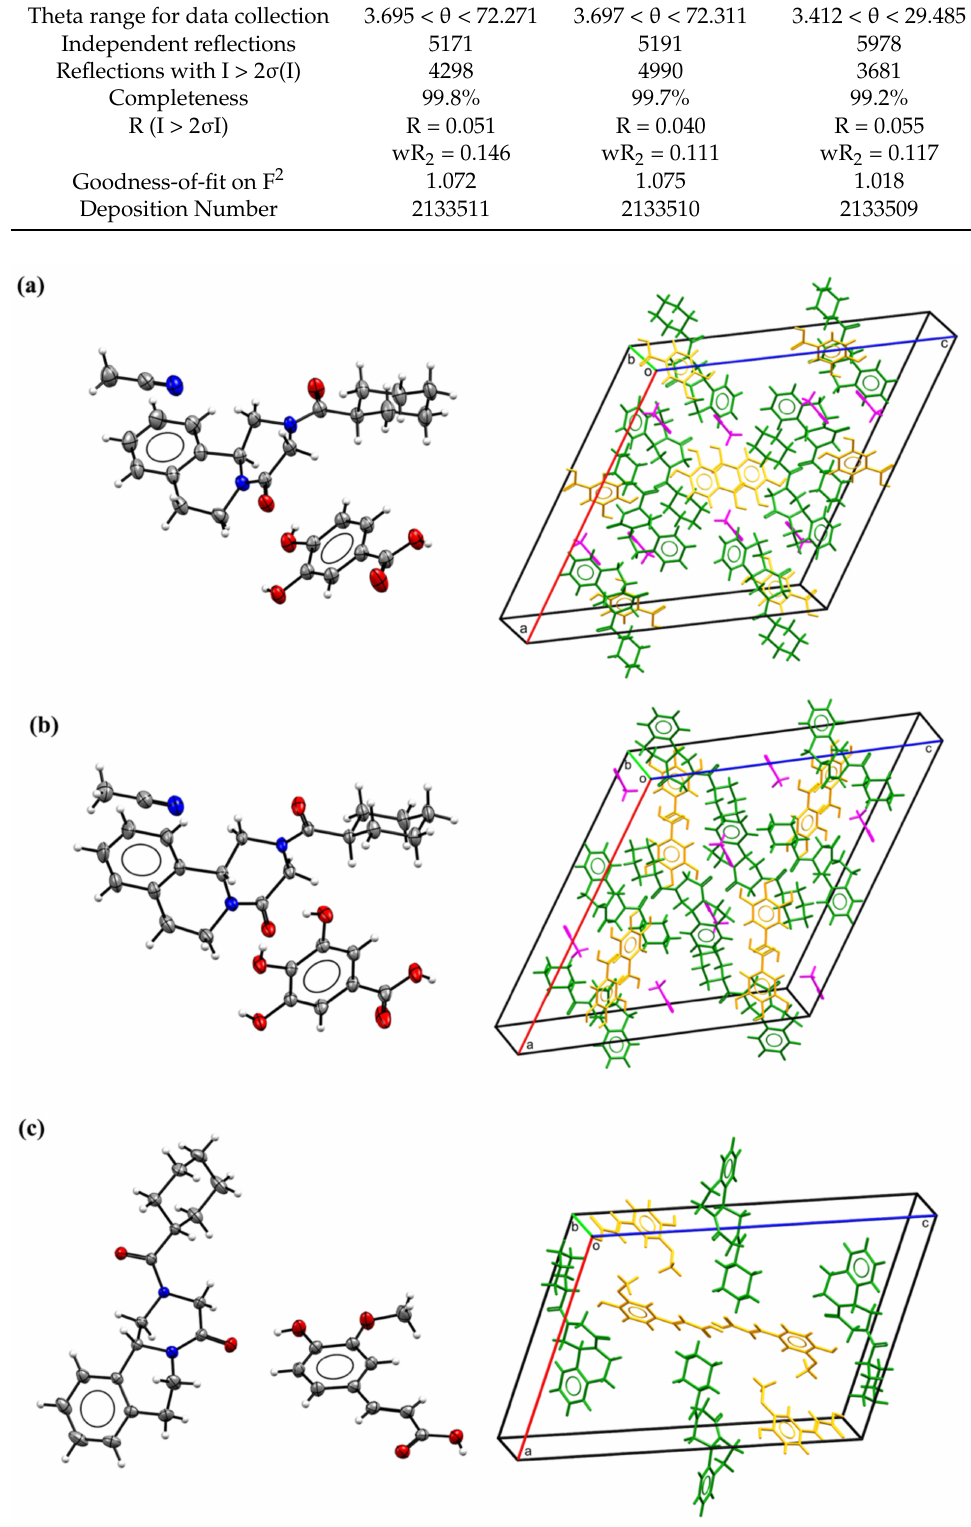
Figure 1. Thermal ellipsoid drawing ( left ) and molecular packing in a unit cell ( right ) of the cocrystals: ( a ) PRA-PA-ACN; ( b ) PRA-GA-ACN; ( c )